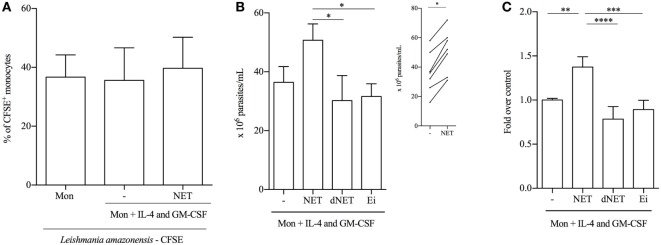
Neutrophil extracellular traps (NETs)-treated monocytes are less efficient in parasite killing. (A) Adhered monocytes were treated with NET for 18 h at 37°C/5%CO2. After 18 h of incubation, CFSE-labeled promastigotes of Leishmania amazonensis were added and cocultured at 35°C/5%CO2. Monocytes were then analyzed on a FACSCalibur flow cytometer (Becton Dickinson). CFSE+ cells were considered as monocytes that bound to or phagocytosed parasites. Results of six independent experiments are shown as mean ± SEM. (B,C) Adhered monocytes were treated with digested, elastase inhibitor-treated, or non-treated NETs or with L. amazonensis supernatant for 18 h at 37°C/5%CO2. Cells were then washed and promastigotes were added to the culture in a 1 monocyte:3 parasites ratio and cocultured at 35°C/5%CO2 overnight. After 48 h of infection, monocytes were lysed with 0.01% sodium dodecyl sulfate and Schneider medium supplemented with 10% FBS was added to the cultures to allow parasites grow. Viable and motile parasites were counted after 48 h in a Neubauer chamber. Results of five to seven independent experiments are shown as mean ± SEM. *P < 0.05. Insert shows the number of parasites in NET-treated and -untreated monocytes. In the insert graph, paired t-test analysis was performed and *P < 0.01. (C) Untreated monocytes (first column) were normalized and data are expressed as fold over the control. (C) ****, ***, **P < 0.01.